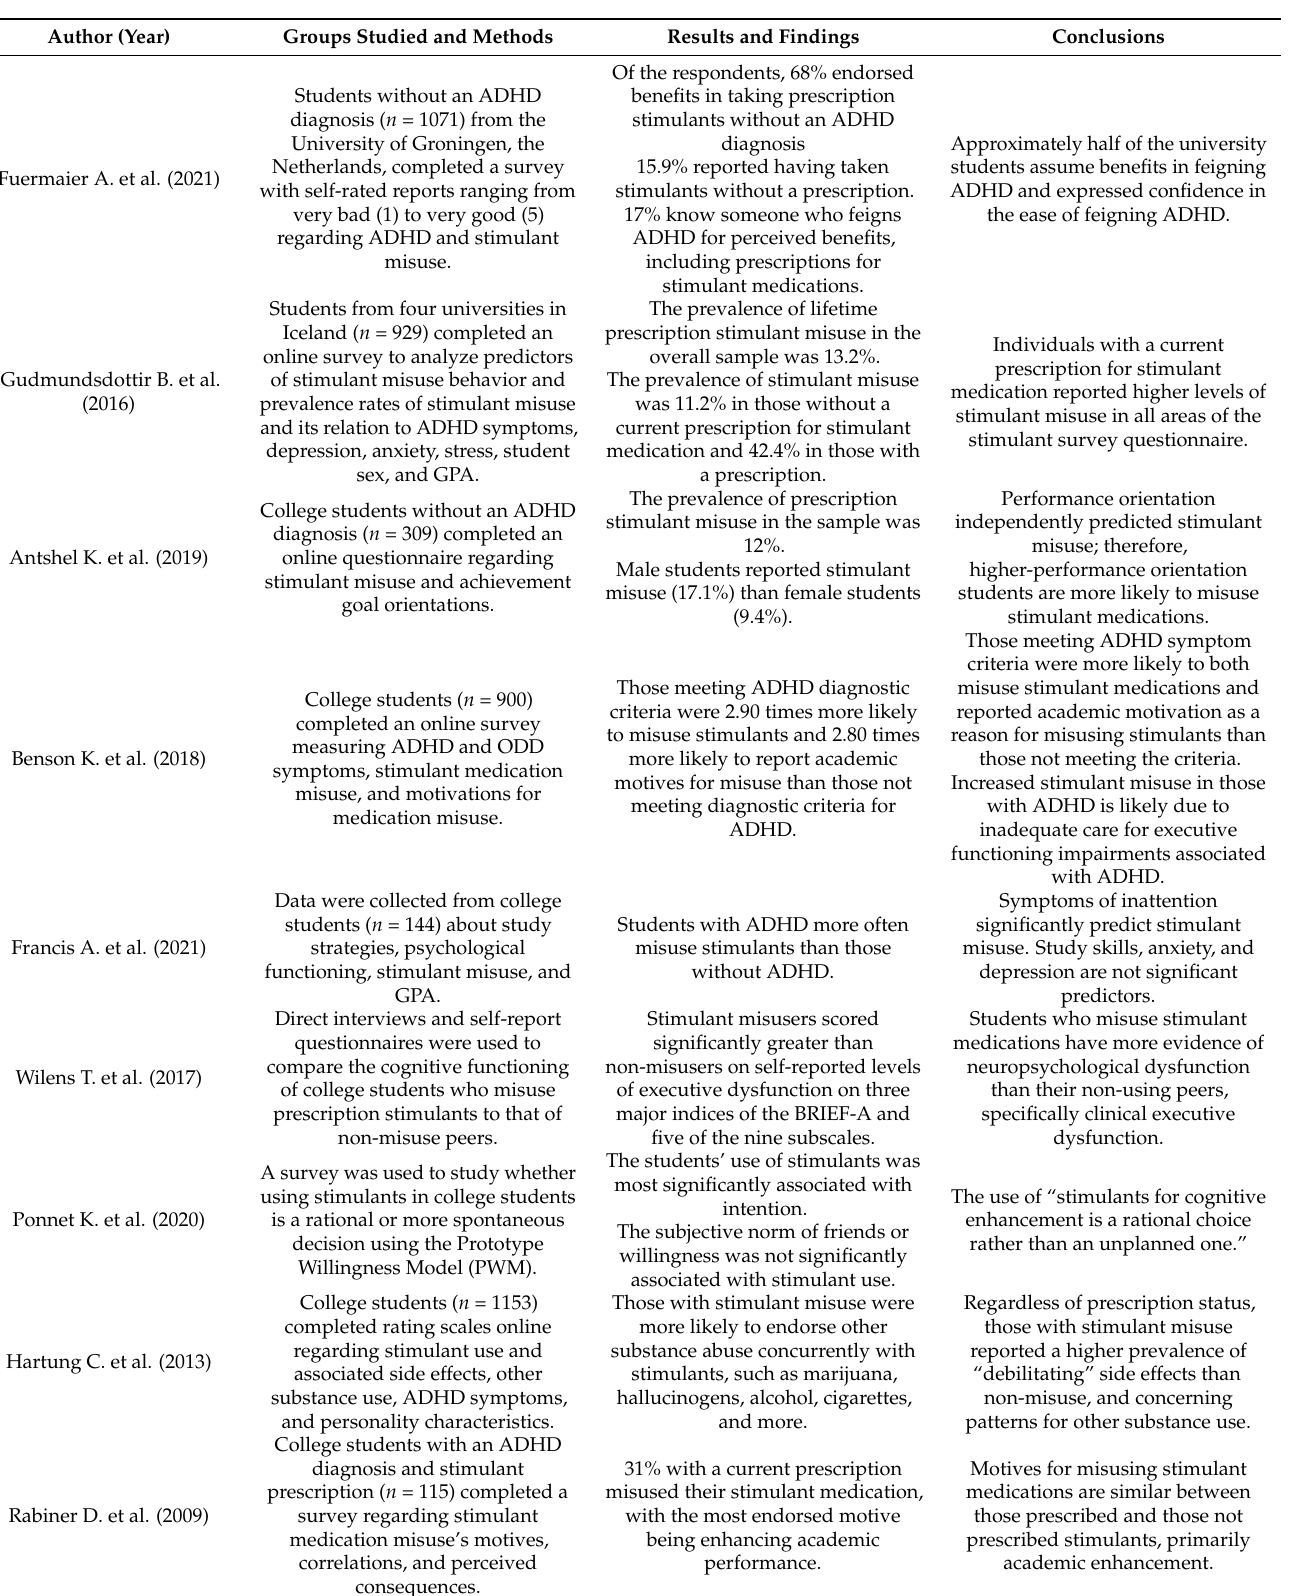
Table 1. Studies in the